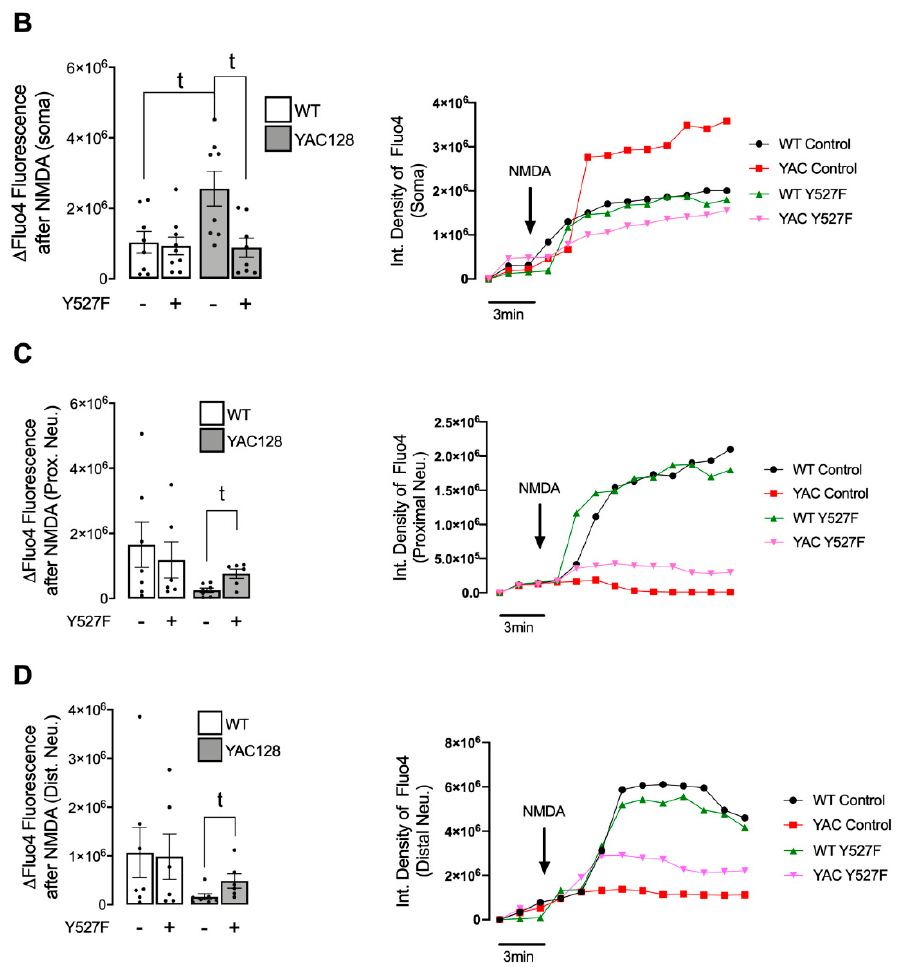
Figure 4. Overexpression of activated SKF partially restores NMDARs currents levels in HD neurons. ( A ) Representative traces of NMDA (100 µ M)-induced inward currents ( − 60 mV holding potential; with 10 µ M glycine; without Mg 2+ ) in striatal neurons from wild-type (WT) and YAC128 mice showing a higher NMDA-induced current density in YAC128 mice-derived neurons vs. WT-derived neurons, partially restored after expression of SKF Y527F , as quantitatively summarized in the histogram. Data are expressed as the mean ± SEM of peak NMDA-induced current density (pA/pF). Statistical analysis: t p < 0.05, tt p < 0.01 by unpaired Student’s t -test. ( B – D ) Intracellular Ca 2+ levels were measured using Fluo4 fluorescent dye, in soma ( B ), proximal neurites, ( C ) and distal neurites ( D ) units of fluorescence were monitored before (3 min) and after (15 min) exposure to 100 µ M NMDA, in medium without Mg 2+ and supplemented with glycine (20 µ M) and serine (30 µ M) in primary striatal neurons from WT and YAC128 mice, using fluorescence microscopy. Data are presented as the mean ± SEM of 4 independent experiments considering ~3 wells/condition. Statistical analysis: t p < 0.05, compared with WT control or YAC128 control (nonparametric Mann-Whitney